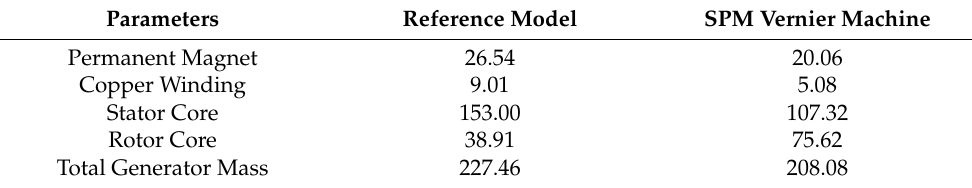
Table 3. Active Material Consumption